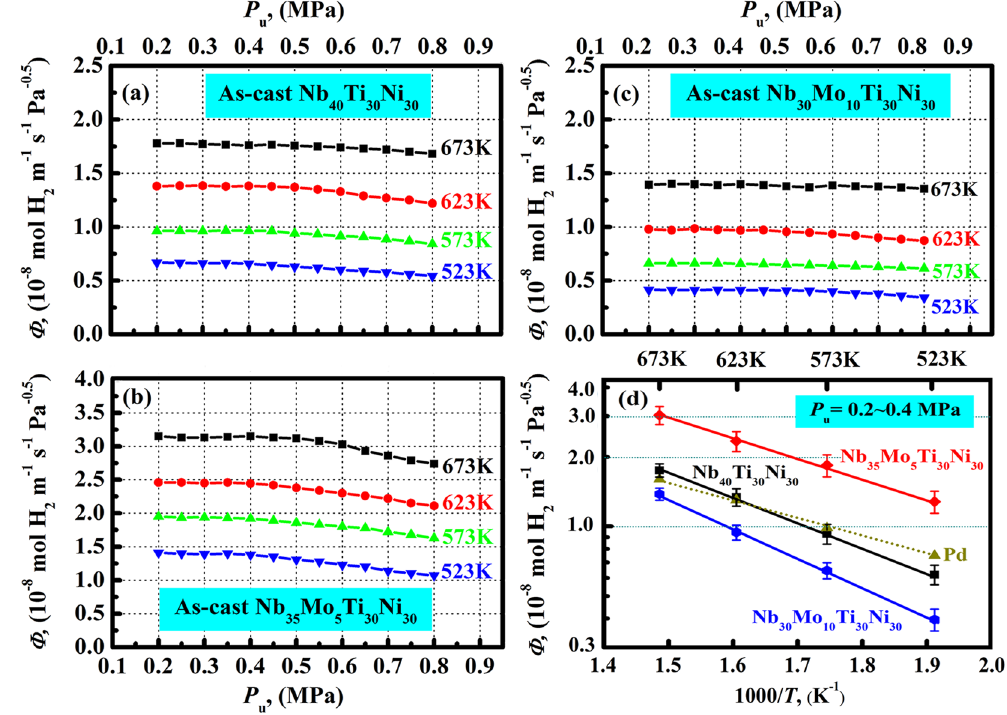
Figure 6. Calculated hydrogen permeability plotted against the upstream pressure ( P u ) for the as-cast